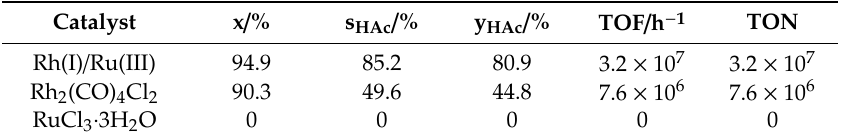
Table 1. Catalytic performance of Rh(I) / Ru(III), RuCl 3 · 3H 2 O, and Rh 2 (CO) 4 Cl 2 for methyl acetate carbonylation. Catalyst x / % s HAc / % y HAc / % TOF / h − 1 TON Rh(I) / Ru(III) 94.9